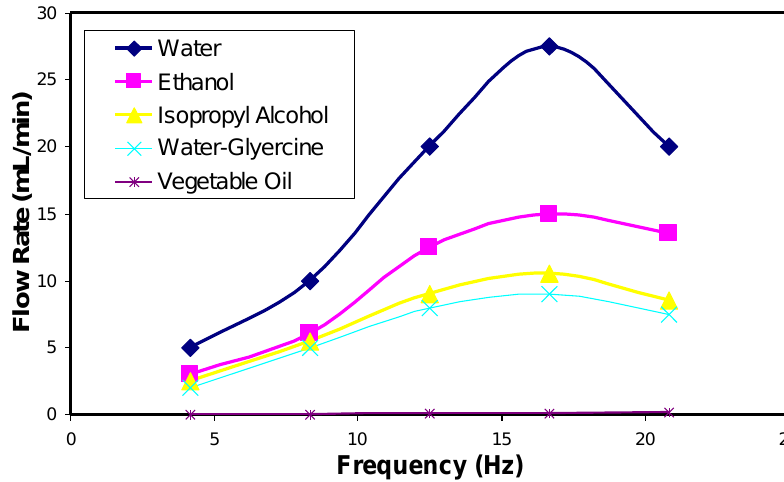
Figure 5. Flow rate through the designed microdevice for drug transport/pumping of different fluid media at various actuating frequencies.